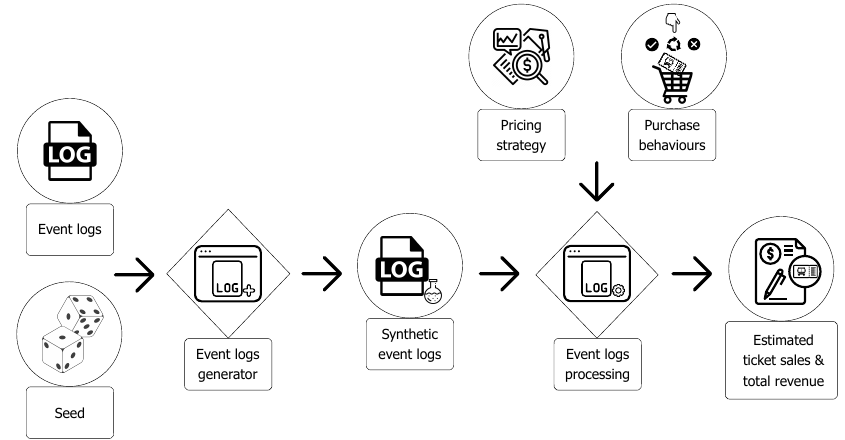
Figure 2. Evaluation steps of a dynamic pricing